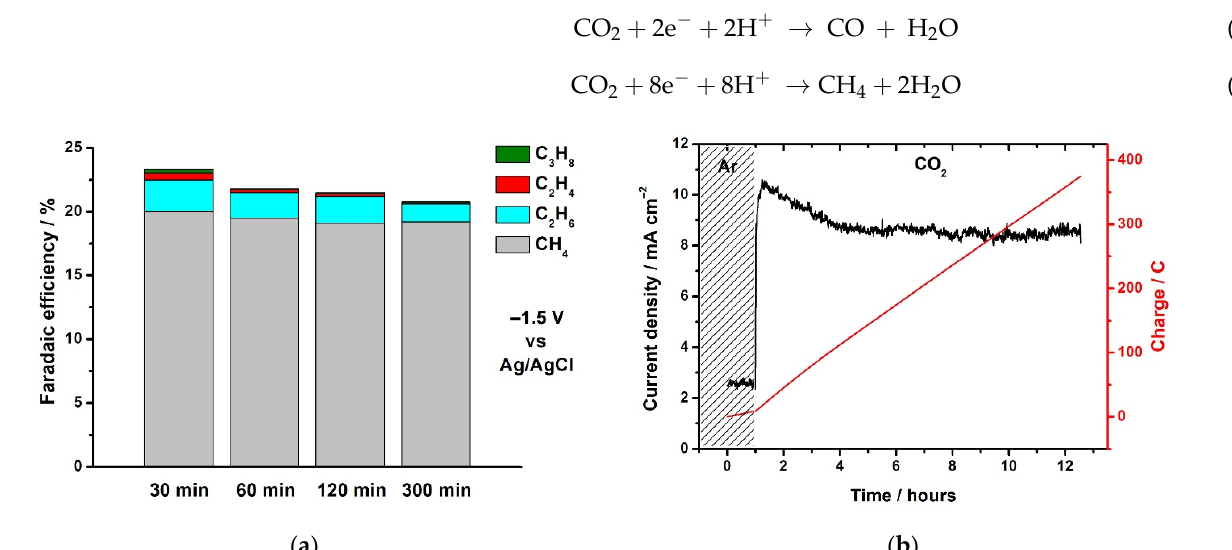
Figure 3. ( a ) Products of the CO 2 RR in the presence of the PG-NaCu complex at − 1.5 V vs. Ag/AgCl after different electrolysis times, ( b ) current density (black trace, left) and charge (red trace, right) during bulk electrolysis (E = − 1.5 V vs. Ag/AgCl) in homogeneous conditions with the PG-NaCu complex in Ar (the first hour) and CO 2 saturated water.